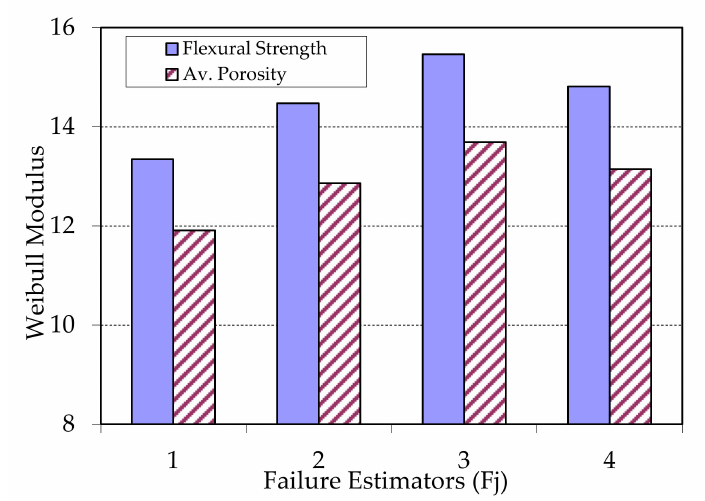
Figure 13. Weibull modulus vs. chosen estimators (Fj = 1 to 4) samples type G1 and for both key